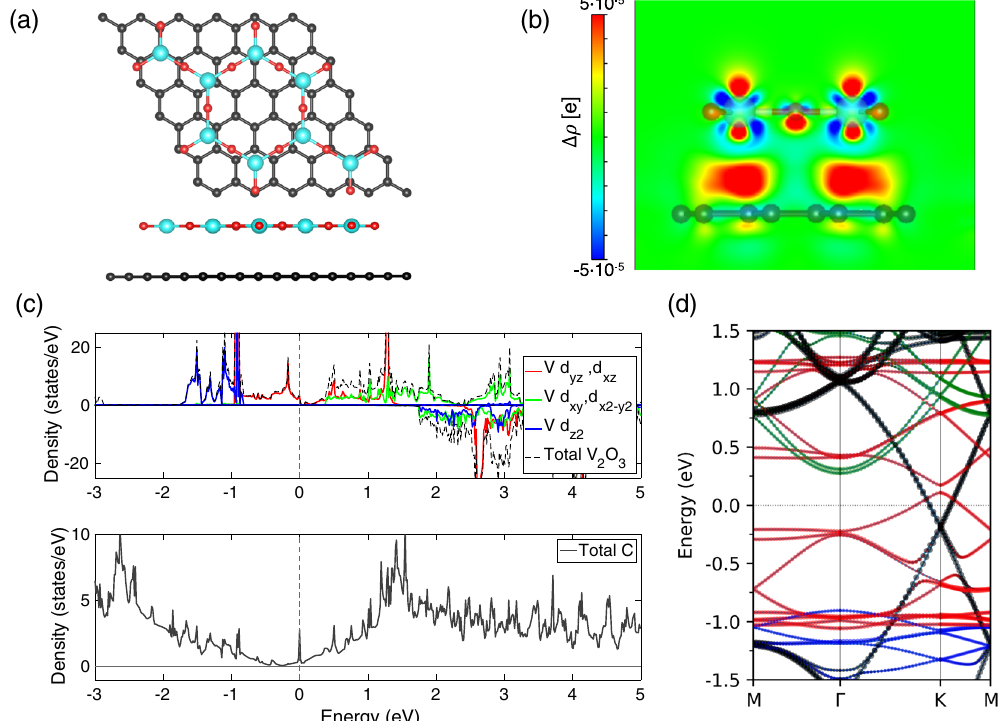
Fig. 5 Graphene substrate study. a The top and side view of (2 × 2) V 2 O 3 supercell on a (5 × 5) graphene supercell. b The calculated charge density difference Δ ρ where blue and red correspond to excess and depleted charge density, respectively. c The DOS within GGA + U and ( d ) band structure of 2D HK V 2 O 3 op graphene within GGA + U + SOC. The color code is the same used in ( c